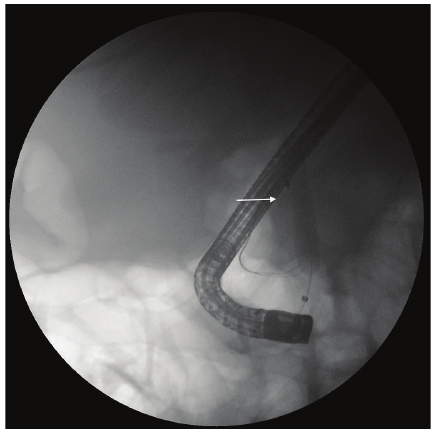
Figure 5: Inflation of a 12 mm dilating balloon beside the stone/ basket complex (arrow) in the distal CBD.